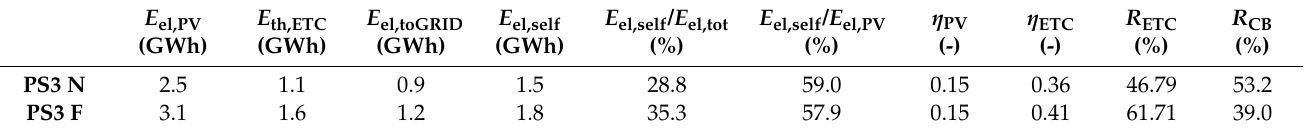
Table 12. Annual results of the renewable system (PS3) for the districts located in Naples and Fayoum.